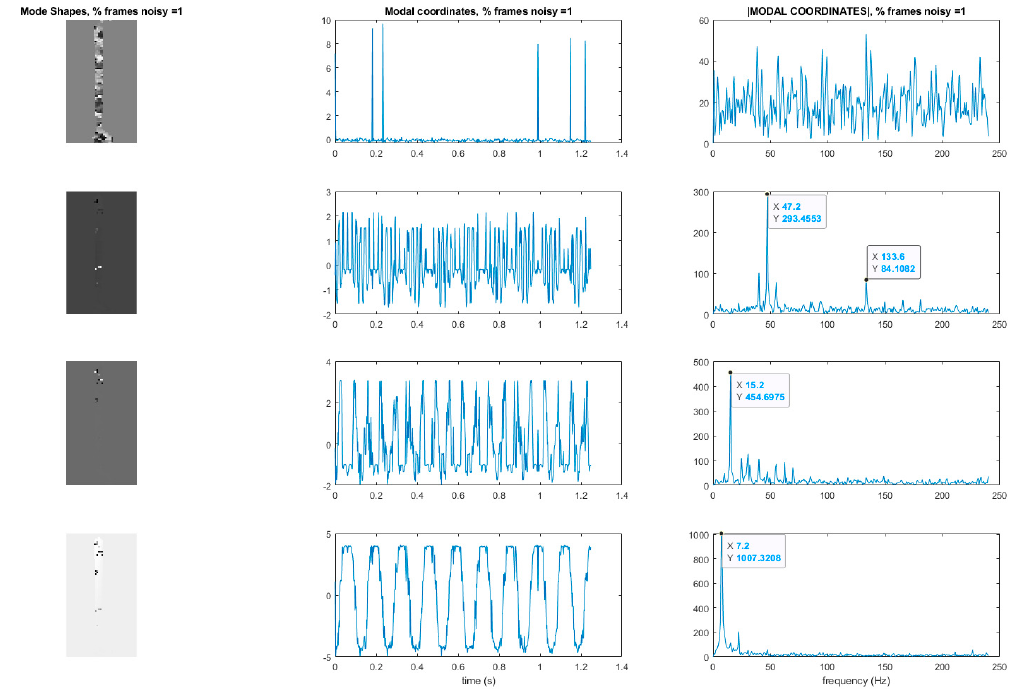
Figure 11. Mode shapes and modal coordinates of the cantilever beam recovered when 1% of the frames are randomly replaced by static frames. Y -axis of the modal coordinate and the magnitude of the fft(modal coordinate) plots are arbitrarily scaled displacement.